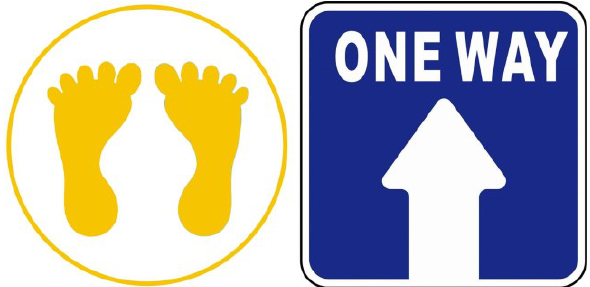
the direction to go